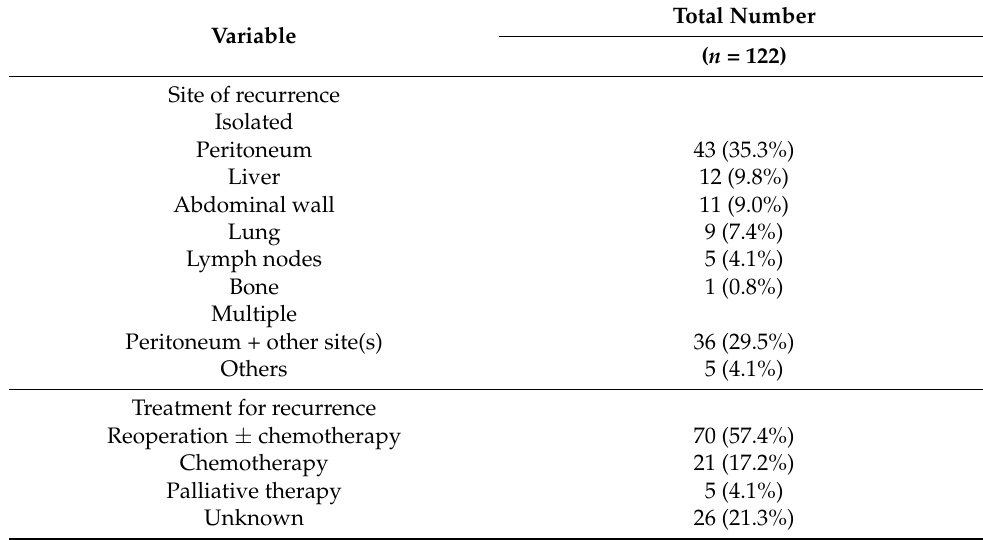
Table 3. Site of recurrence and treatment for